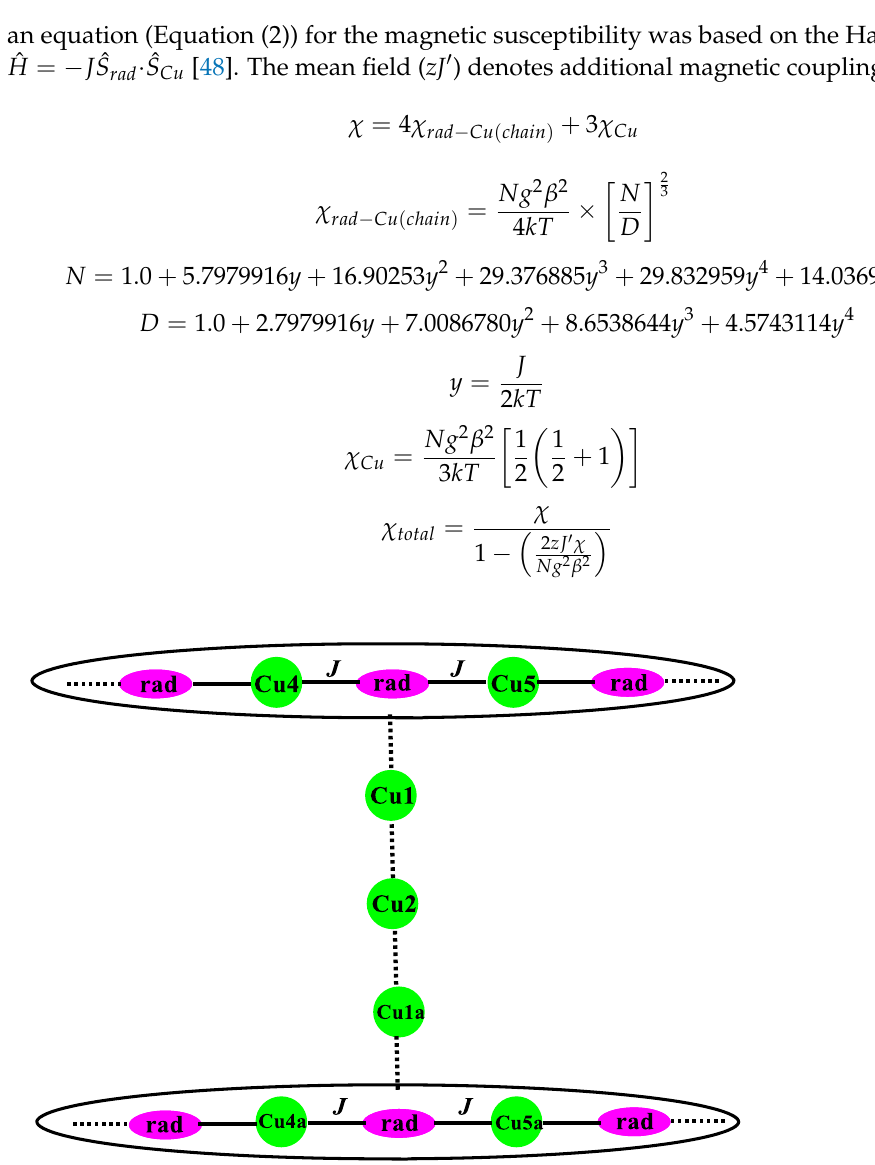
Scheme 2. Magnetic exchange model in 1